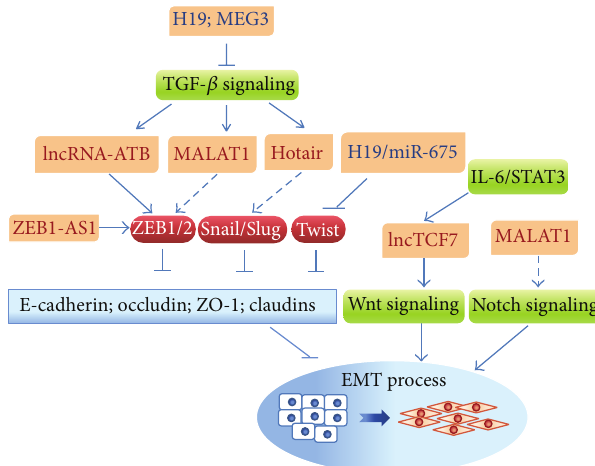
Figure 2: The reciprocally regulatory feedback loop between lncRNAs and EMT-TFs that are involved in EMT. lncRNAs form regulatory networks with EMT-TFs and EMT-associated signaling pathways that individually or cooperatively modulate EMT. The EMT-suppressive lncRNAs, H19 and MEG3, can downregulate TGF- 𝛽 signaling. H19, lncRNA-ATB, and ZEB-AS1 promote EMT- TFs through direct or indirect regulation. In addition, H19 is reported to possess a controversial ability to downregulate Twist though its intergenic miRNA, miR-675. TGF- 𝛽 and IL-6/STAT3 signaling pathways also promote activity of the lncRNAs, Hotair, lncTCF7, and MALAT1, and thus crosstalk with Notch signaling and Wnt signaling, to modulate EMT process. Dysregulation of these miRNAs and lncRNAs may lead to tumor